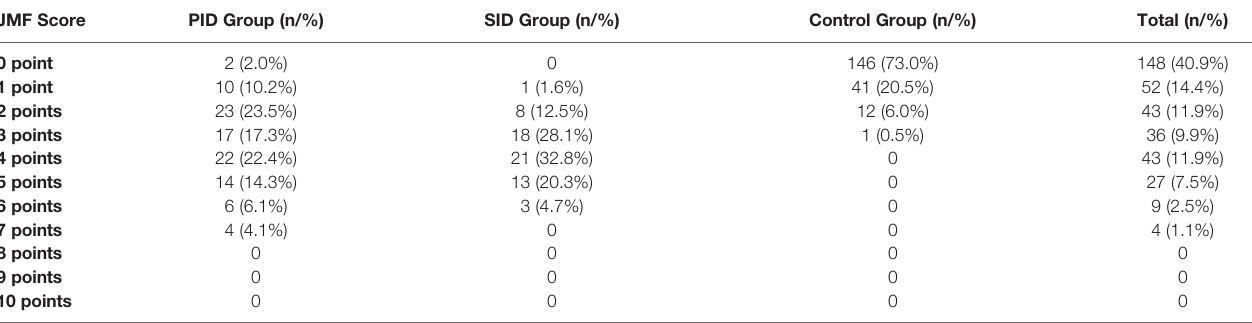
TABLE 1E | Distribution of JMF scores of the PID, SID and Control